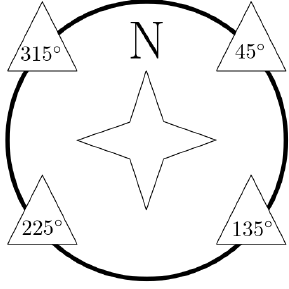
Figure 4. Positions of the strain gauges around the circumference of the tower.